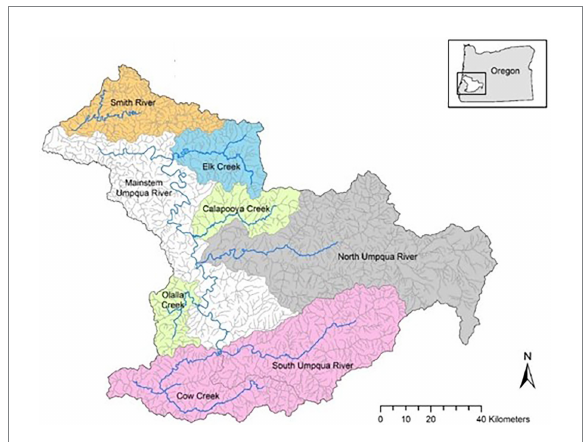
FIGURE 1 The eight watersheds (labeled) in the Umpqua basin where native Umpqua chub and non-native smallmouth bass were snorkel surveyed from 2006 to 2021 with location in Oregon, United States (box). Colors represent distinct evolutionary populations of Umpqua chub (O’Malley et al., 2013). Map reproduced with permission from ODFW